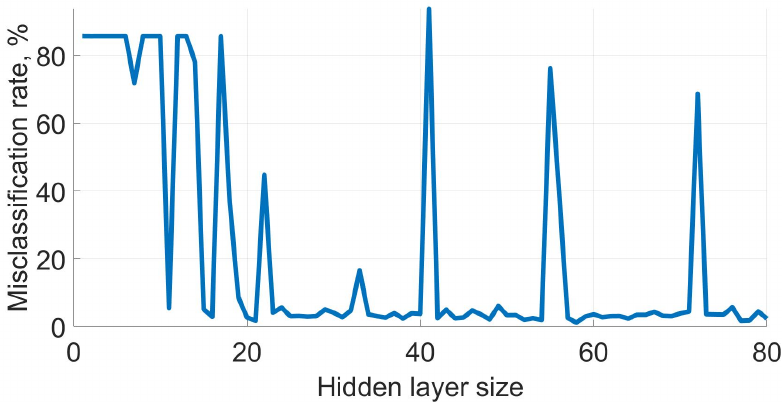
Figure 5. Misclassification rates of single layer ANN with varying number of nodes.